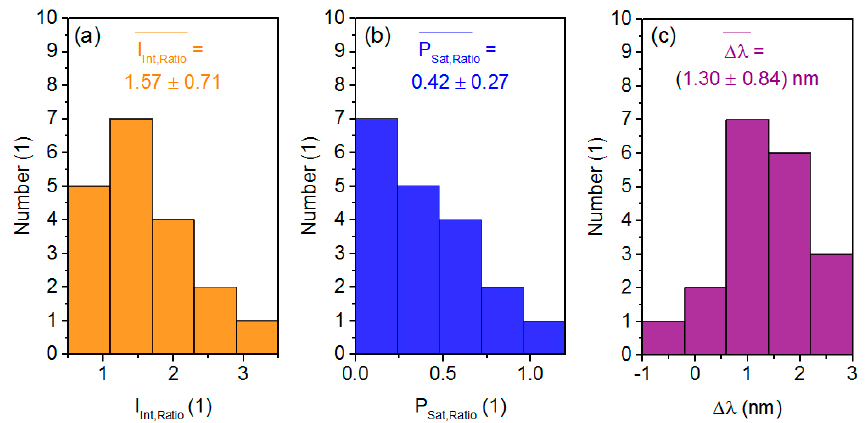
Figure 2. Statistical analysis performed on 19 QDs for ( a ) the ratio of the integrated intensities I Int, Ratio ; ( b ) the ratio of saturation power P Int, Ratio ; and ( c ) the spectral shift of the investigated QD emission line Δλ each before and after the coating with Ta 2 O 5 .